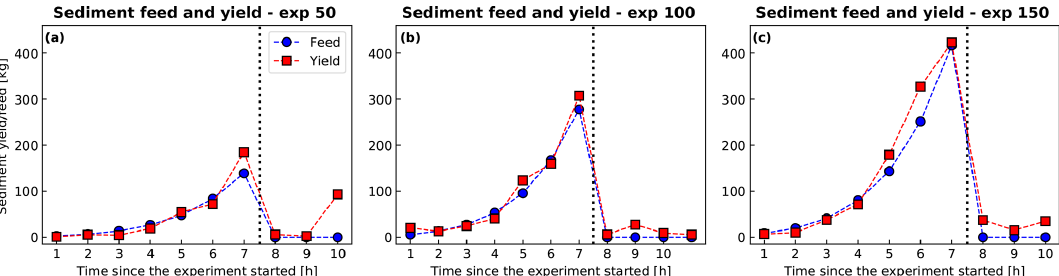
Figure 11. Sediment yield (red squares) measured at the channel outlet and sediment feed (blue circles) at the channel inlet in Experiments (a) 50, (b) 100, and (c) 150. The vertical dashed line indicates when the sediment feed was turned off.